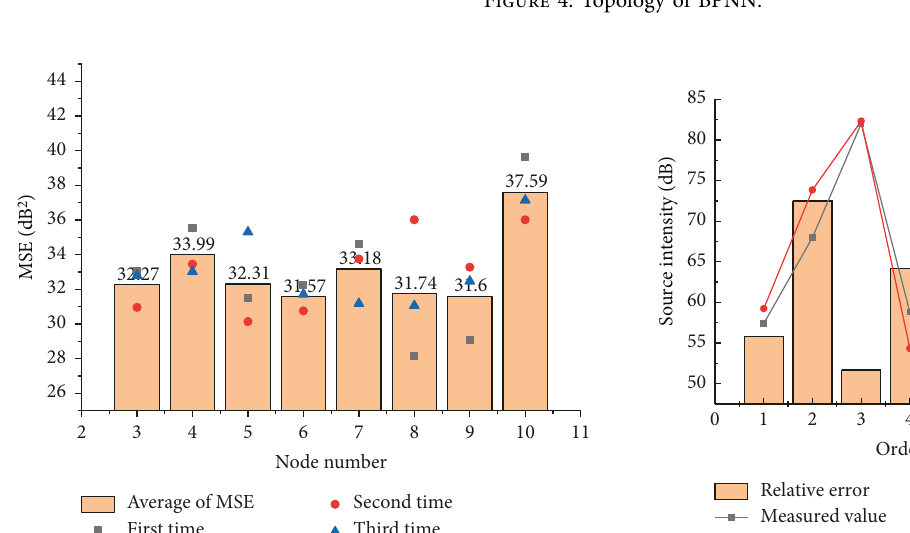
Figure 4: Topology of BPNN.